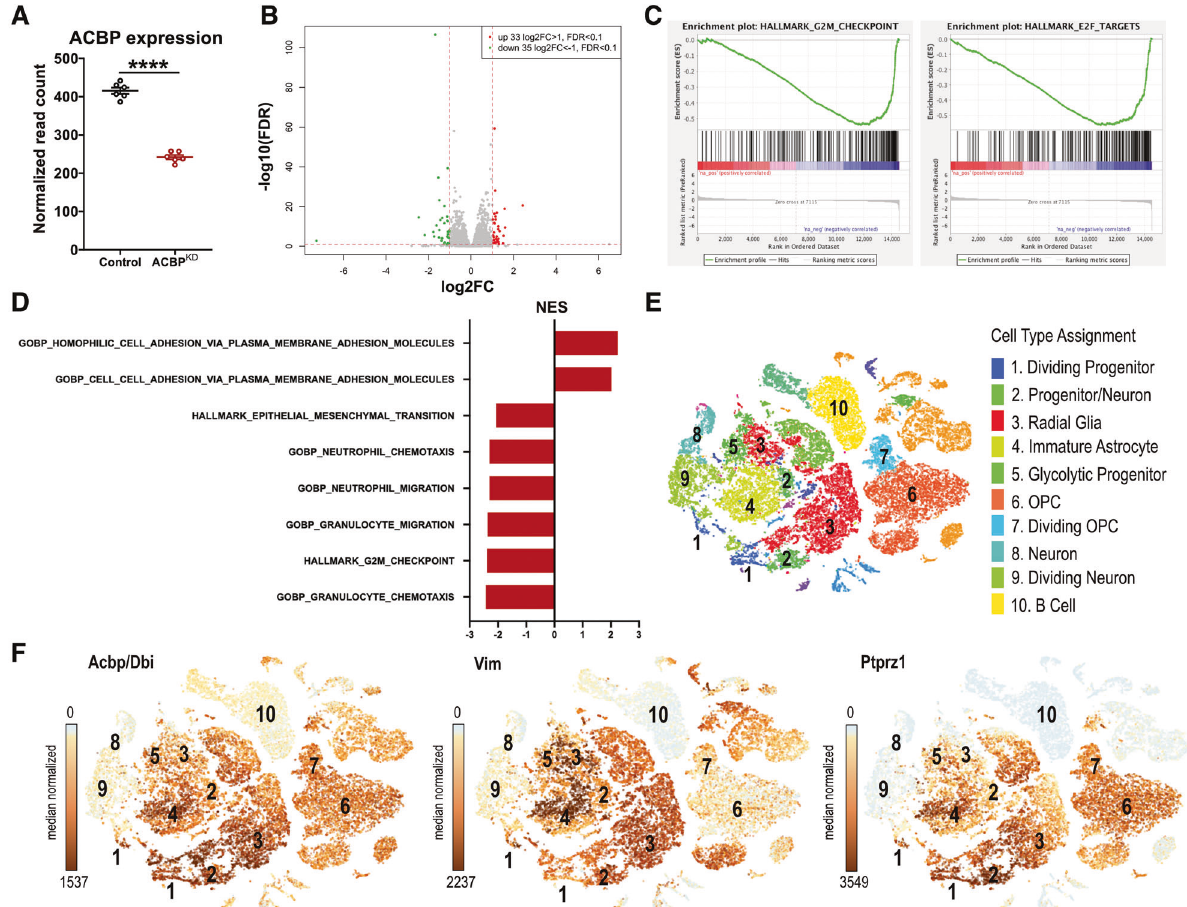
Fig. 1 ACBP downregulation affects cell migration and invasion transcriptional pathways in GBM cells. A LN229 GBM cells were transduced with lentiviruses expressing either shRNA scrambled (Control) or shRNA1 against ACBP (ACBP KD ) and collected one week later for bulk mRNAseq. The graph shows normalized number of reads for ACBP in each condition (mean ± SEM, n = 6 samples per group, unpaired t-test **** p < 0.0001). B Volcano plot of RNAseq results comparing Control vs ACBP KD global expression levels. C Gene set enrichment analysis (GSEA) of cell division-related pathways (left: Hallmark G2M Checkpoint, right: Hallmark E2F Targets) downregulated in ACBP KD cells. D Gene Set enrichment analysis in Control vs ACBP KD cells. Normalized Enrichment Score (NES) negative values indicate pathways enriched in Control cells, while positive NES values show pathways enriched in ACBP KD cells. All pathways displayed have FDR q-val < 0.05. E tSNE plot showing primary GBM tumor cell clustering with cell type annotations [22] obtained from single-cell mRNA sequencing data available at https:// gbm.cells.ucsc.edu. F Feature plots of ACBP and invasion-associated genes Vimentin and